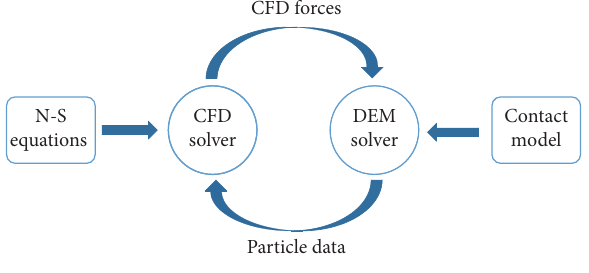
Figure 3: CFD-EDM coupling. Table 1: Main geometric parameters of the model pump. Impeller parameters Guide vane